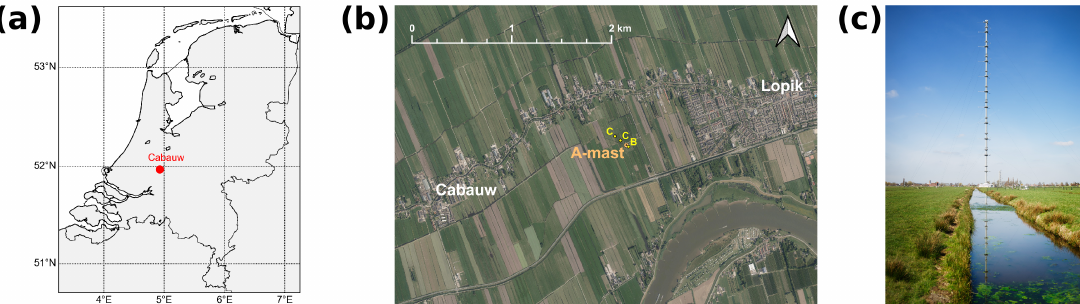
Figure 2. Overview of the Cabauw site. ( a ) Map of the Netherlands, indicating the location of measurement site near Cabauw (51.971 ◦ N, 4.927 ◦ E). ( b ) Aerial image of the surroundings, indicating the locations of the masts at the measurement site, and the nearby villages Cabauw and Lopik (image from PDOK Landelijke Voorziening Beeldmateriaal, Luchtfoto 2019 Ortho 25 cm RGB). ( c ) The 213-m tall A-mast (photo by Ruben Jorksveld,